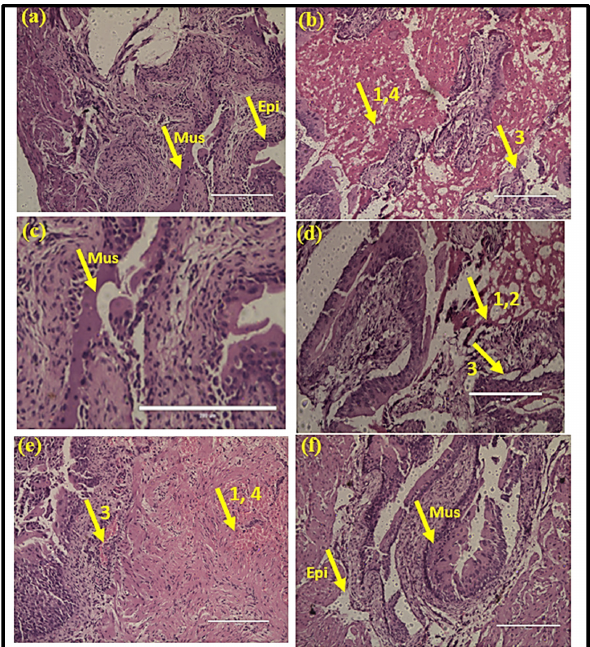
Figure 5. Histopathology analysis of bladder tissue: ( a ) normal uninfected mice (PBS), ( b ) infection control, ( c ) drug-only control, ( d ) heraclenol treatment (Below MIC), ( e ) heraclenol treatment (MIC), ( f ) heraclenol treatment (above MIC). 1: inflammation, 2: abrasion, 3: congestion, 4: hemorrhage, Mus: muscularis, Epi: epithelium.